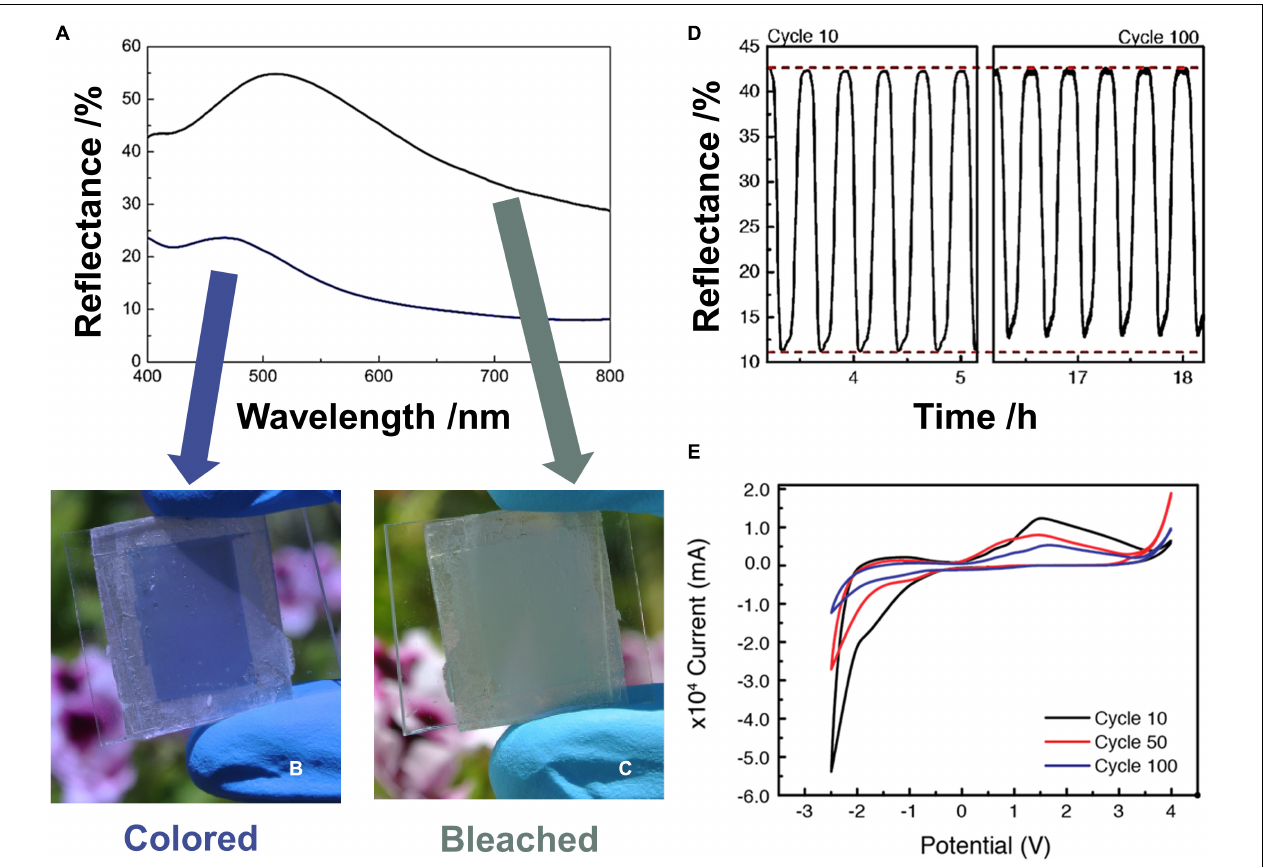
FIGURE 5 | (A) Reflectance and (B,C) photographs the ECD in the bleached and colored states. (D) Lifetime cycles measurements and (E) cyclic voltammograms of the